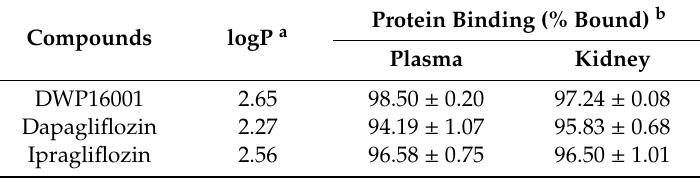
Table 2. Protein binding of DWP16001, dapagliflozin, and ipragliflozin in mouse plasma and kidney